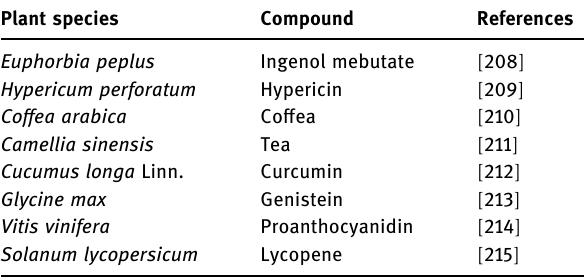
Table 2: Green synthesized silver nanoparticles Plant